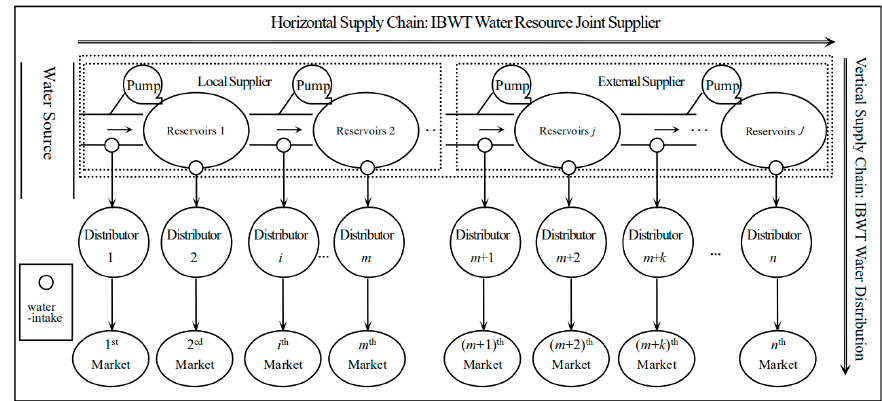
Figure 1. A Generic Inter-Basin Water Transfer Supply Chain System.